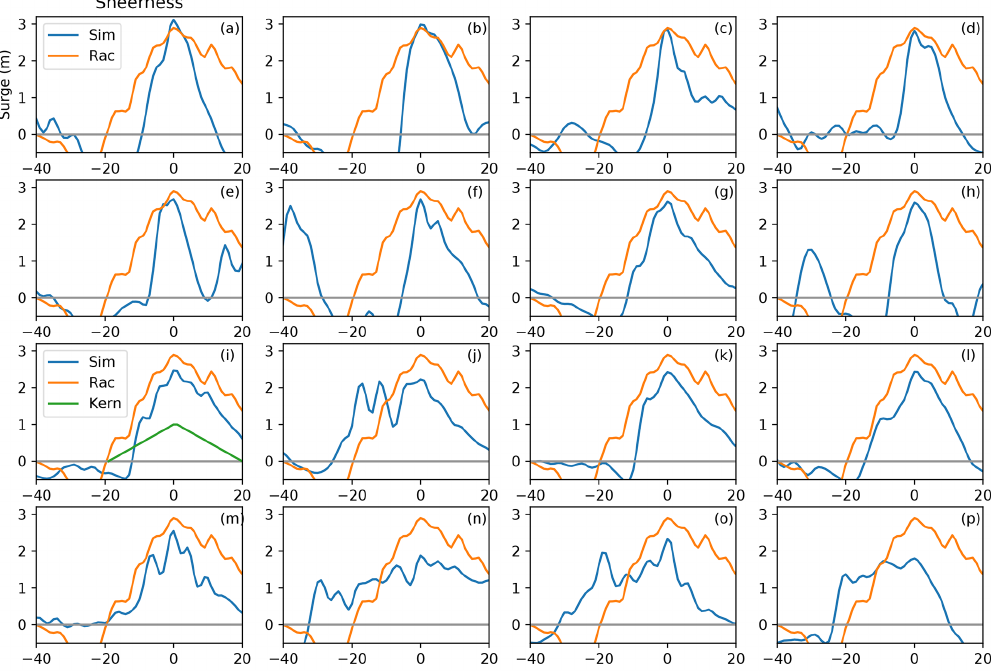
Figure 6. A total of 16 events from the HadGEM3-GC3-MM surge-only simulation (“Sim”), in each case compared with the RACMO-driven surge only simulation (“Rac”). Panels (a) – (h) show the eight largest independent surge-only events. Panels (i) – (p) show events which are both large and have substantial duration (the original time series before convolution is shown). X axis is time in hours with arbitrary